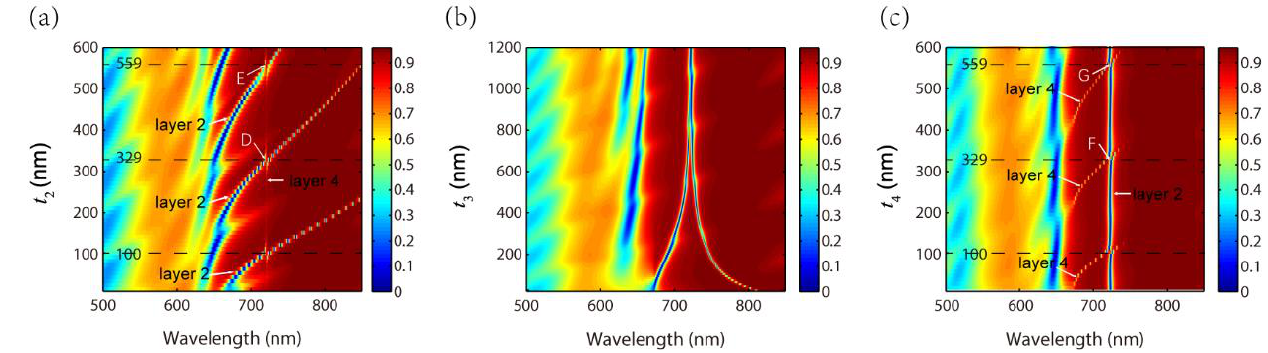
t , ( b ) t and ( c ) 2 3 2 , ( b ) t 3 and ( c ) t 4